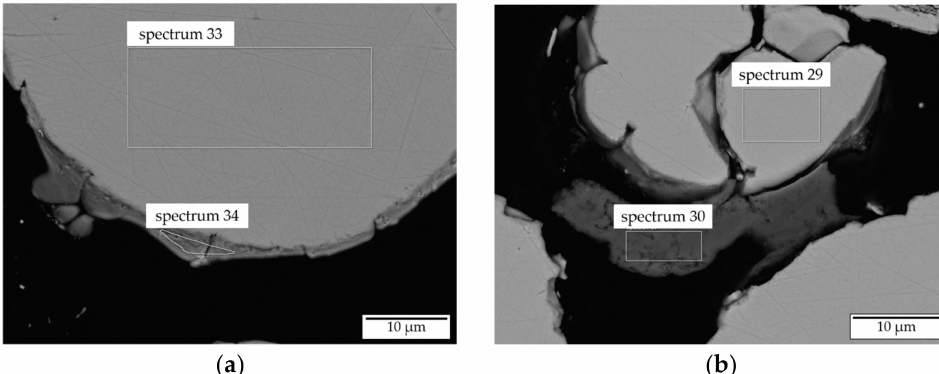
Figure 7. SEM images of Ni50Al50 powder cross sections with the marked regions investigated by EDX (( a )—region 33 and 34; ( b )—region 29 and 30).